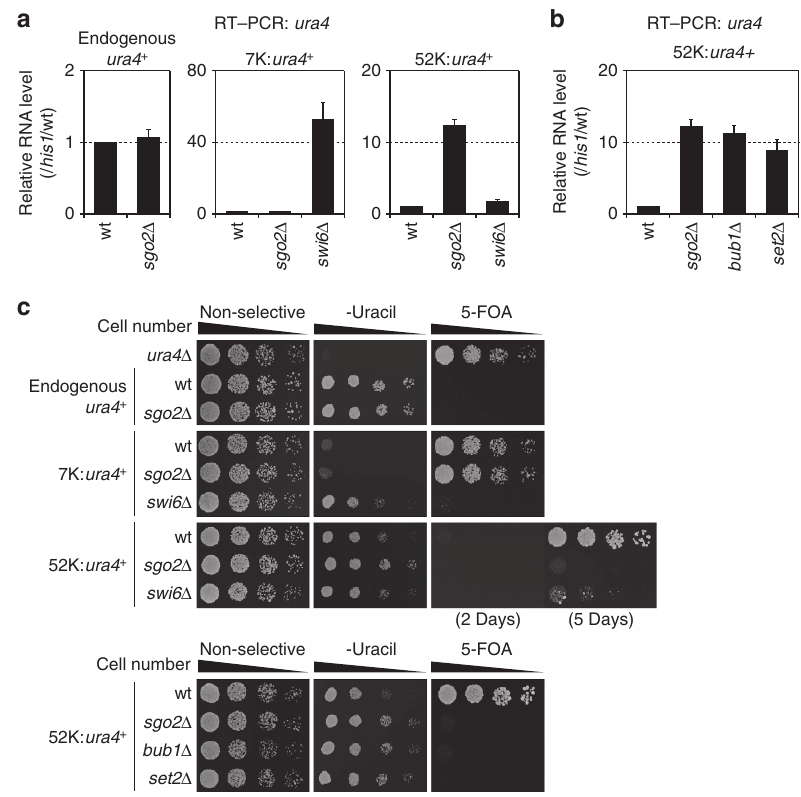
Figure 6 | Sgo2 forms a transcriptionally repressed chromatin domain distinct from Swi6/HP1 heterochromatin. ( a ) The absence of Sgo2 and Swi6 has different effects on the repression of subtelomeric genes. The RNA level of the ura4 þ gene in each strain was analysed by quantitative reverse transcriptase–PCR (RT–PCR); left, endogenous ura4 þ ; middle, ura4 þ inserted at 7kb from tel2R ; right, ura4 þ inserted at 52kb from tel2R . Each value of ura4 þ relative to that of his1 þ was re-normalized to the wt value. Error bars indicate the s.d. ( n ¼ 3). ( b ) RNA expression of the ura4 þ gene in bub1 D and set2 D cells was analysed as in a . ( c ) Growth assays of the strains used in a and b . Dilution series of cells were spotted on YES (non-selective complete medium), SD-uracil (lacking uracil) and 5-FOA (YES with 1mgml (cid:2) 1 5-fluoroorotic acid, the counter-selection drug for ura4 þ ) plates at 32 (cid:2) C for 2 days unless otherwise indicated. The ura4 D strain (top) was the control for the assay. It is noteworthy that 5 days incubation was necessary to see growth on 5-FOA for 52K: ura4 þ due to the lower level of gene repression as compared with the that 7K: ura4 þ